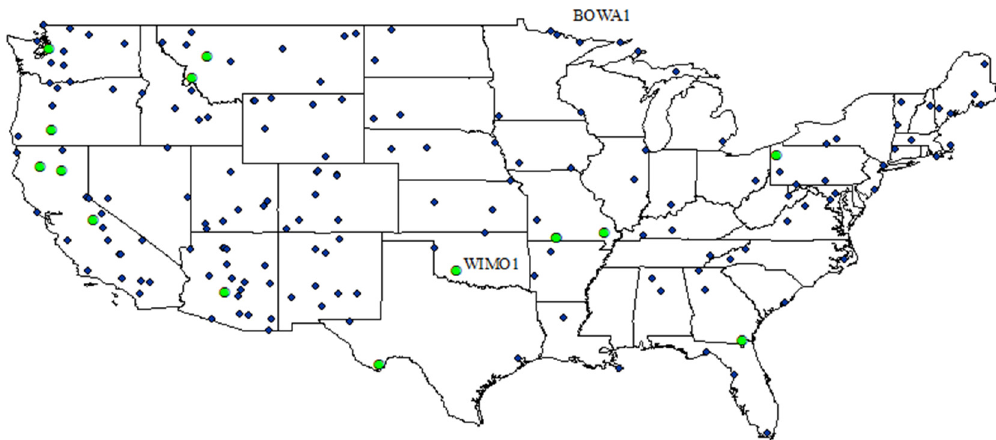
Figure 1. Locations of IMPROVE monitors (marked as ● ) over the contiguous United States. The 15 sites (marked as ) indicate the locations where most fire events have been identified from 2001 to 2011 using the approach developed in this work.